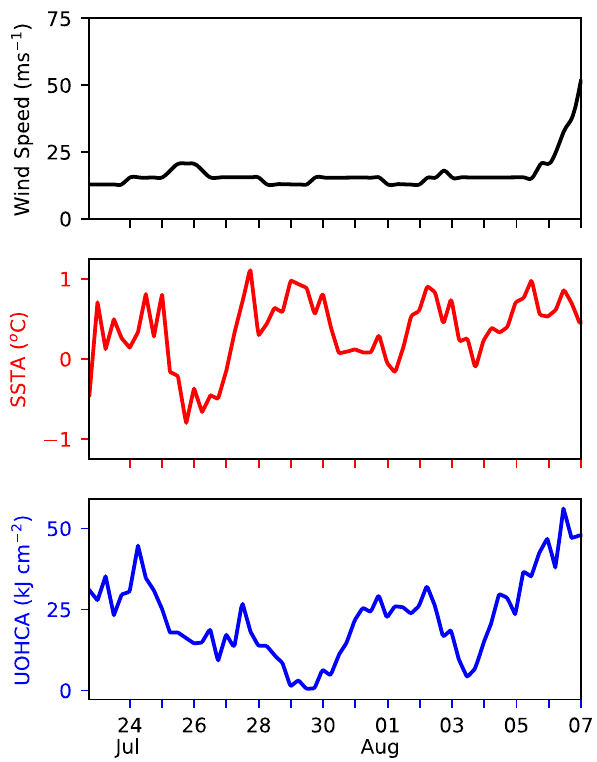
Figure 5. Along-track time series record for Hurricane Genevieve through ( Top ) maximum sustained wind speed with TC intensity category indicated, ( Center ) SST anomaly, and ( Bottom ) UOHC